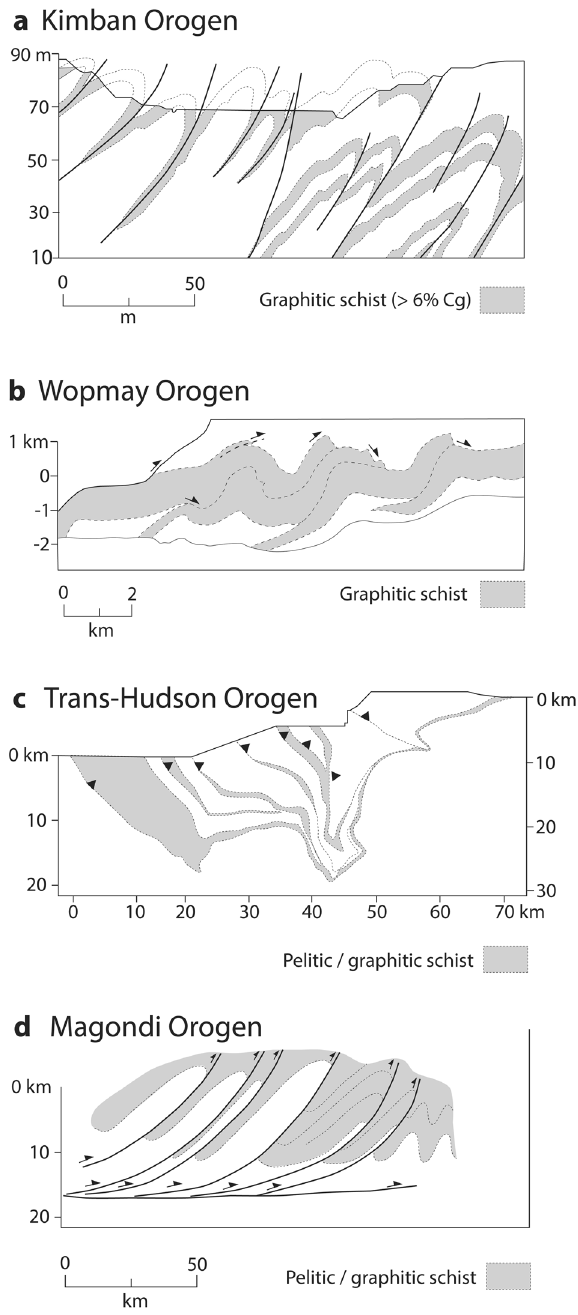
Fig. 4 Cross-sections through Palaeoproterozoic orogenic belts, deformed within pelitic/graphitic sediments. Sections in ( a ) Kimban, ( b ) Wopmay, ( c ) Trans-Hudson, and ( d ) Magondi orogens show imbricate thrust slices detached in carbonaceous sediments, commonly stacked near- vertically 48 – 51 .